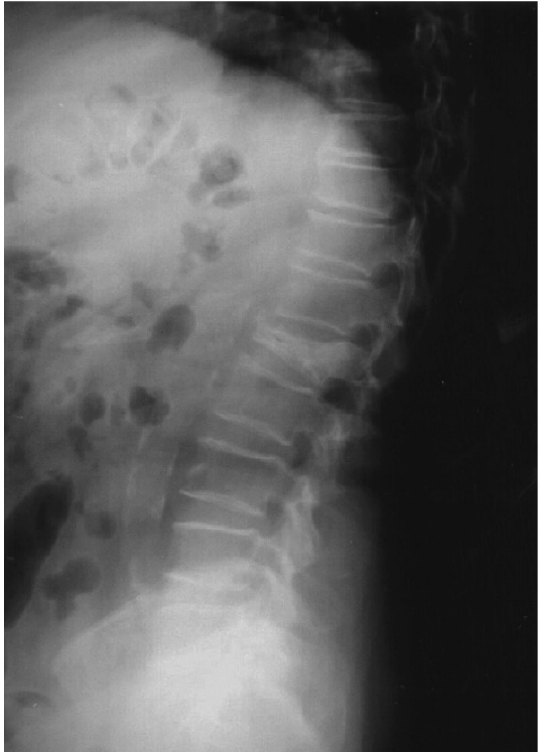
Figure 1. X-ray image of a 71 years old woman with aortic calcifications, low bone density and a vertebral fracture.